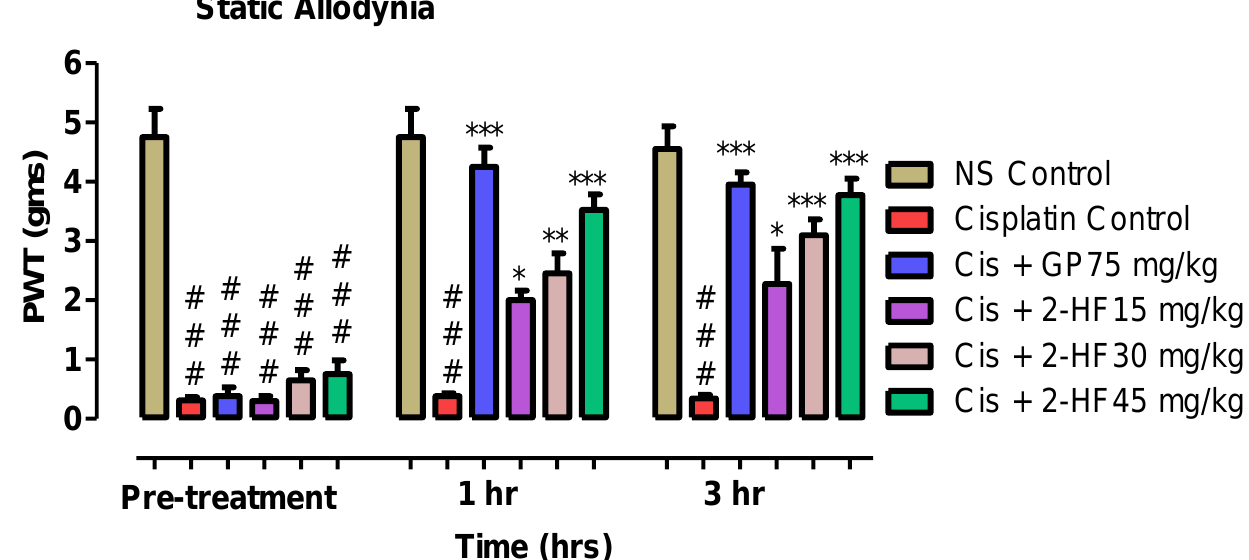
Figure 10. Effect of 2-HF in cisplatin-induced static allodynia. *** p < 0.001, ** p < 0.01, * p < 0.05 for standard drug and cis + 2HF 45 mg kg − 1 , two-way repeated measures ANOVA followed by Tukey’s post hoc test.